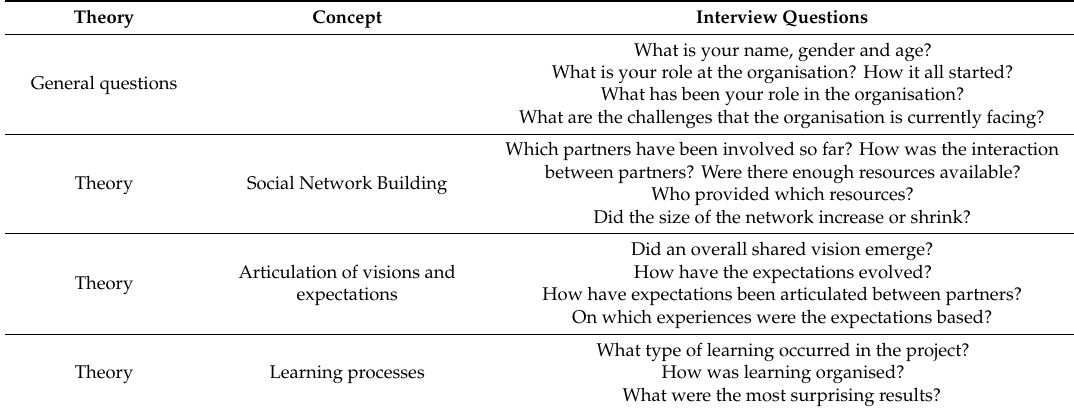
Table 5. Semi-structured interview